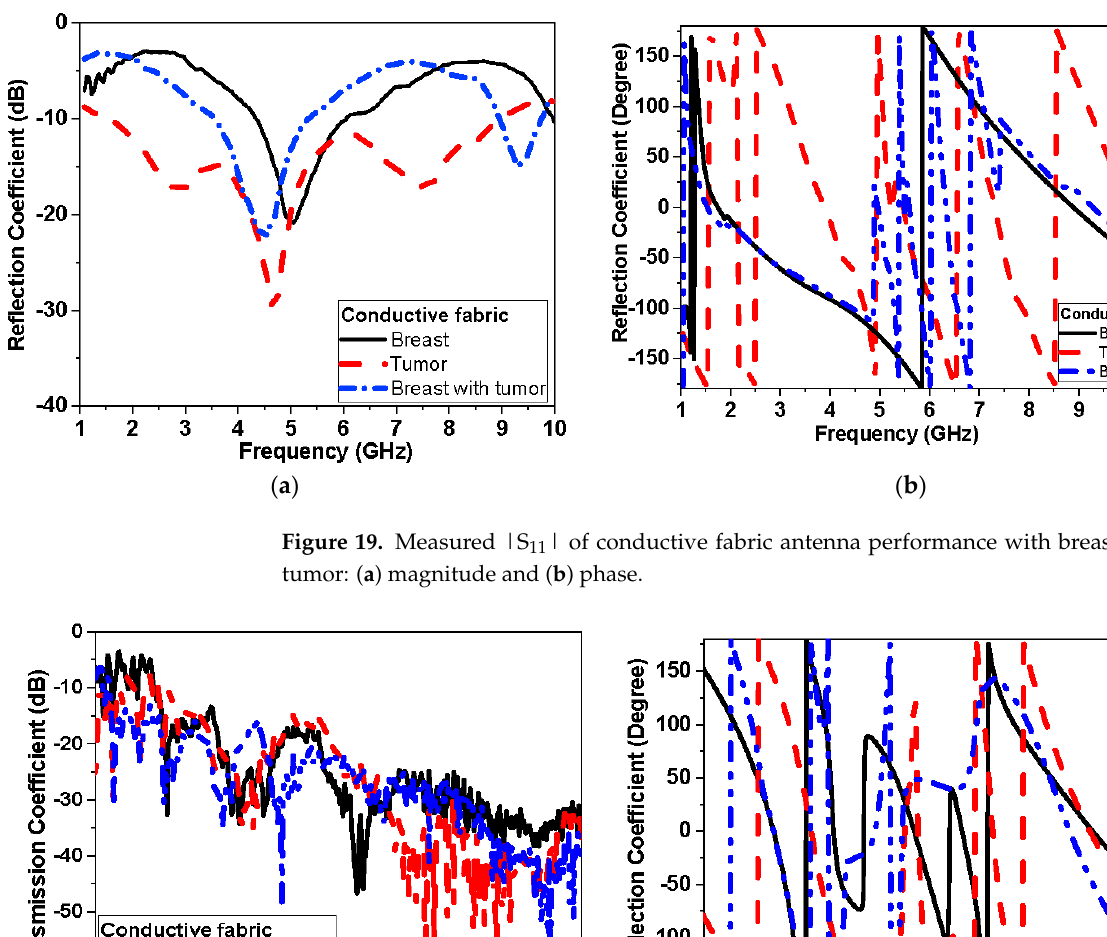
Table 2. Comparison of measured SAR levels for the proposed monopole antenna at 2.45 GHz.